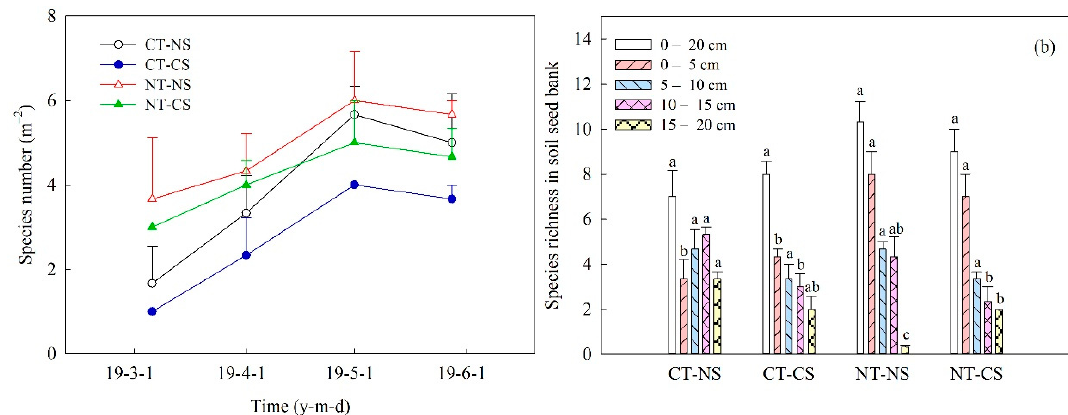
Figure 1. Species richness in vegetation ( a ) and soil seed bank ( b ) under conventional tillage with no crop residue (CT-NS), conventional tillage with crop residue (CT-CS), no-till with no crop residue (NT-NS), and no-till with crop residue (NT-CS). Different letters indicate significant difference among treatments (one-way ANOVA, p < 0.05). Bars represent means ± SE.